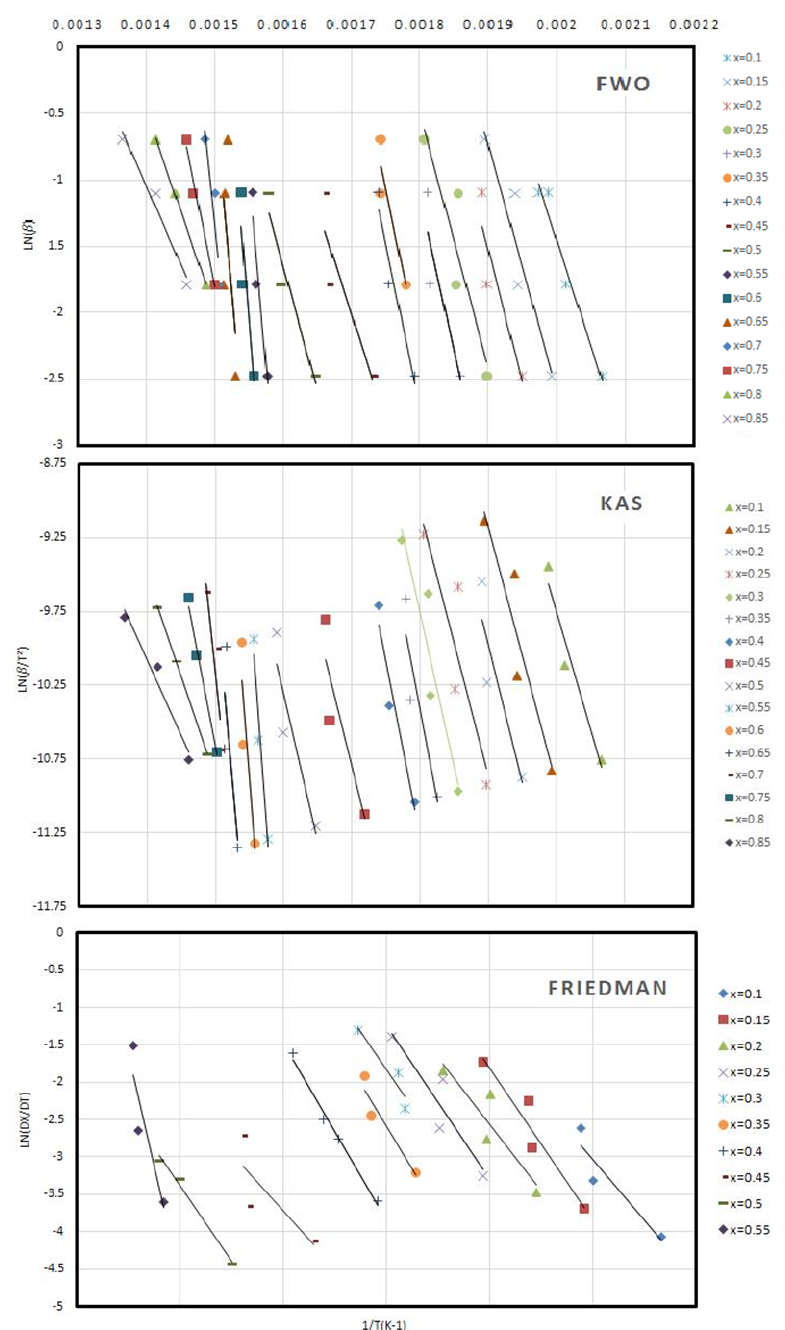
Figure 2. FWO, KAS and Friedman kinetic linear